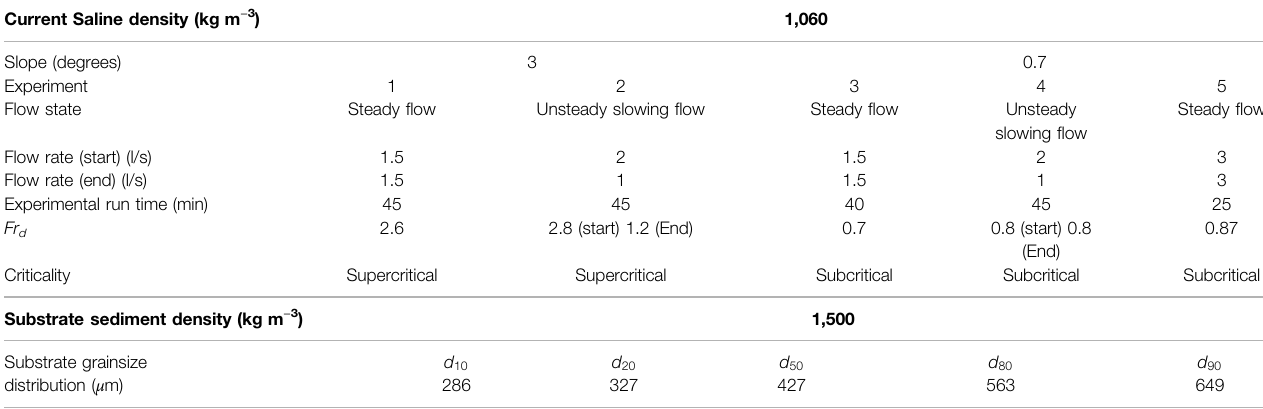
TABLE 1 | Experimental parameters and characteristics of the plastic sediment that was used for the channel substrate used in each experiment. Current Saline density (kg m − 3